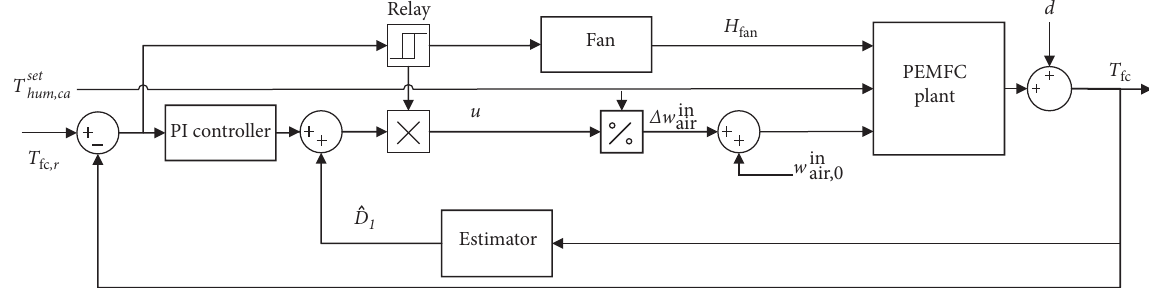
Figure 3: Schematic block of the composite PID